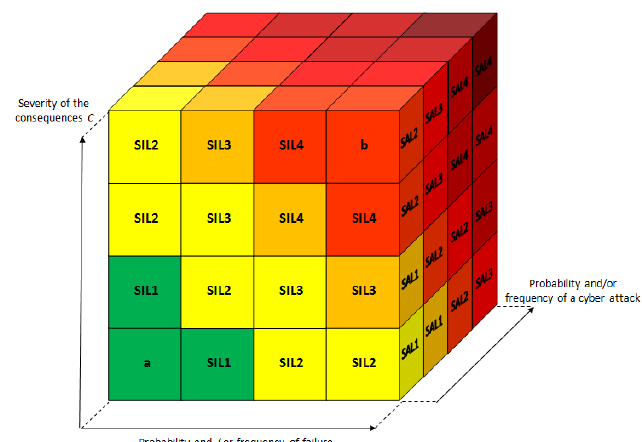
Figure 5. Risk Cube SIL-SAL (col.).